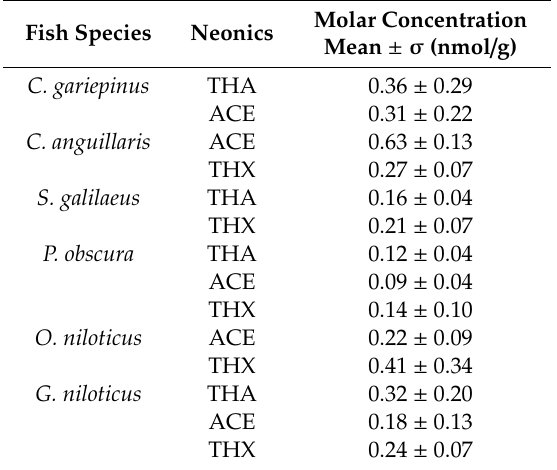
Table 6. Amount of neonics determined in the six Owena River fish species: Thiacloprid (THA), Acetamiprid (ACE) and Thiamethoxam (THX).